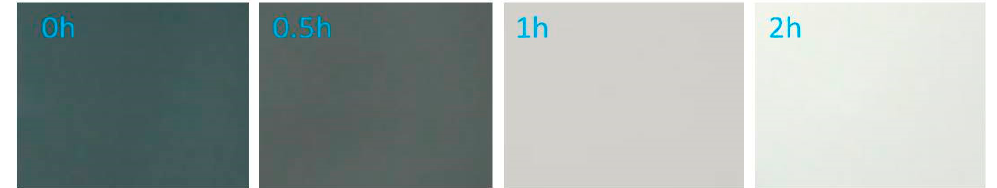
Figure 5. Variation of the color solution for System 1, as a function of the UV irradiation time exposure.